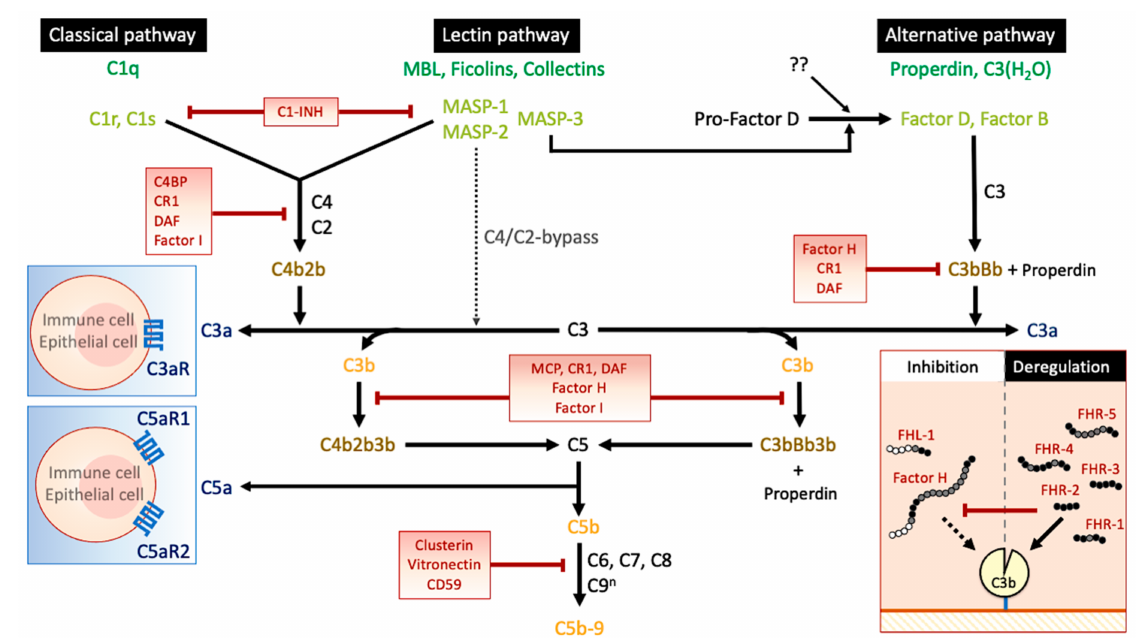
Figure 1. Overview of the complement system. Complement activation can be initiated via three different pathways: the classical pathway, the lectin pathway, and the alternative pathway. The classical pathway begins with the activation of C1, a complex composed of one C1q molecule (the pattern recognition molecule—dark green) as well as two C1r molecules and two C1s molecules (the serine proteases—light green). The lectin pathway begins via any of its pattern recognition molecules (dark green); that is, mannose-binding lectin (MBL), ficolins, or certain collectins, which work together with MBL-associated serine protease 1 (MASP-1) and 2 (MASP-2). Activation of either the classical or the lectin pathway leads to the cleavage of C4 and C2 and the formation of the C4bC2a complex, also known as the C3-convertase (gold). In the alternative pathway, activation occurs via the spontaneously thioester-hydrolyzed form of C3 (C3(H 2 O)) or via surface interactions of properdin (the pattern recognition molecules—dark green), which acts with Factor B and Factor D (the serine proteases—light green) to form the C3-convertase C3bBb (gold). Overall, all three pathways lead to the formation of their respective C3-convertases (gold), which in turn cleave C3 into C3a (an anaphylatoxin—blue) and the opsonin C3b (yellow). MASP-2 has also been shown to directly cleave native C3, thereby bypassing C2 and C4 in the activation of the lectin pathway; this is also known as the C4/C2 bypass mechanism (grey). Recently, MASP-3 was revealed to cleave pro-Factor D into Factor D, establishing a novel link between the lectin and alternative pathway. Although MASP-3 is responsible for the main activation of pro-Factor D, there is also an unknown alternative pro-Factor D activator. Increasing densities of C3b through activation of C3 by the C3-convertases favors the formation of the C5-convertases (gold). In the classical and lectin pathways, C5-convertase is formed by a complex of C3b with C4b and C2a known as C4b2b3b. In the alternative pathway, an additional C3b binds to the C3 convertase (C3bBb) to form the C5-convertase C3bBb3b. Properdin is a key positive regulator of complement activity which acts by stabilizing alternative pathway C3- and C5-convertases. The C5-convertases (C4b2b3b and/or C3bBb3b, respectively) cleave C5 to generate the potent chemoattractant C5a (an anaphylatoxin—blue) and C5b (yellow), the initial component of the membrane attack complex. Next, C6, C7, C8, and C9 bind serially to surface-bound C5b to form the final complex, C5b-9 (yellow). Further interactions with additional C9 molecules, up to 17 molecules, widens the inner pore of the membrane attack complex. In addition, the anaphylatoxins C3a and C5a bind to their respective receptor (blue), C3a-receptor (C3aR), C5a receptor 1 (C5aR1), and C5a receptor 2 (C5aR2) on target cells to mediate a variety of inflammatory responses. In parallel to these activation pathways, complement regulation is established through membrane-bound and soluble complement inhibitors. In the classical and lectin pathway, C1-inhibitor (C1-INH) regulates the activity of the pattern recognition molecules and associated serine proteases, whereas C4b-binding protein (C4BP) inhibits activation at the C4 level. Factor I and Factor H act on C3- and C5-convertases. In addition, the membrane-bound inhibitors complement receptor 1 (CR1/CD35) and membrane cofactor protein (MCP/CD46) act as co-factors for Factor I, whereas decay-accelerating factor (DAF/CD55) accelerates the decay of C3-convertases. The membrane-bound regulator CD59, as well as soluble regulators clusterin and vitronectin, impair the formation of C5b-9. The Factor H protein family consists of Factor H, Factor H-like protein 1 (FHL-1), and five Factor H-related proteins (FHR). Factor H consists of 20 domains. The first four domains (white) provide the inhibitory function of the protein, while